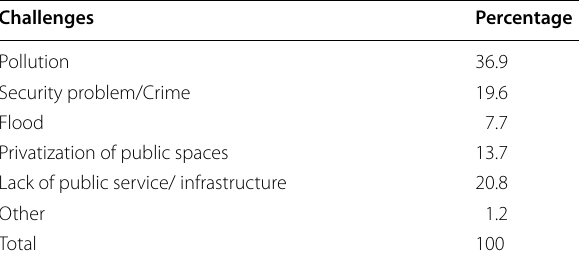
Table 6 Respondent’s response to the challenges of open spaces at the riverside (N =